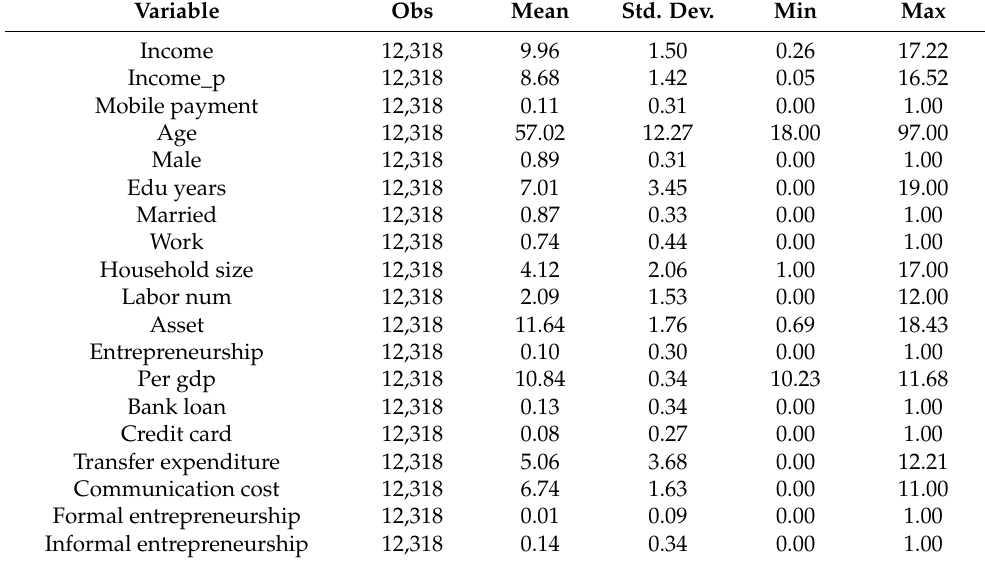
Table 2. Summary Statistics: Key Variables.